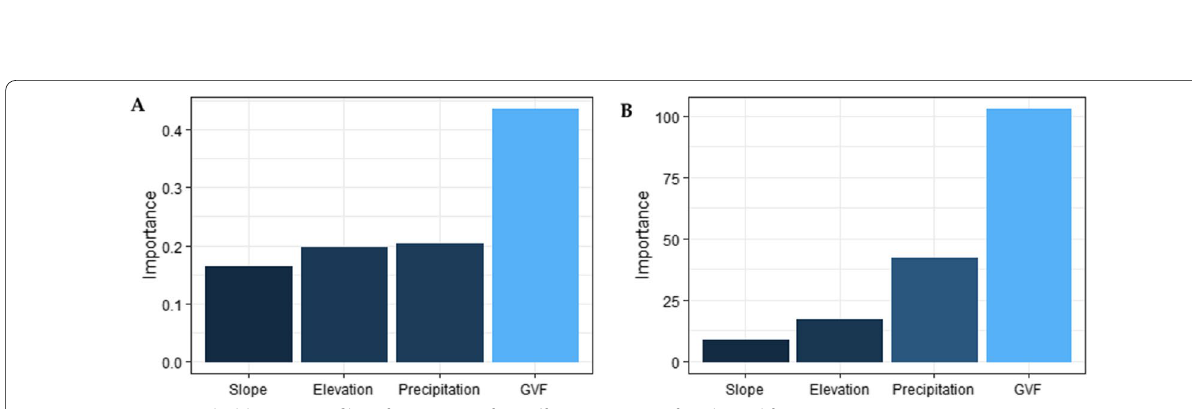
Fig. 10 Garson’s ( A ) and Olden’s ( B ) profiles of Sensitivity of runoff as a response of ecological factors in